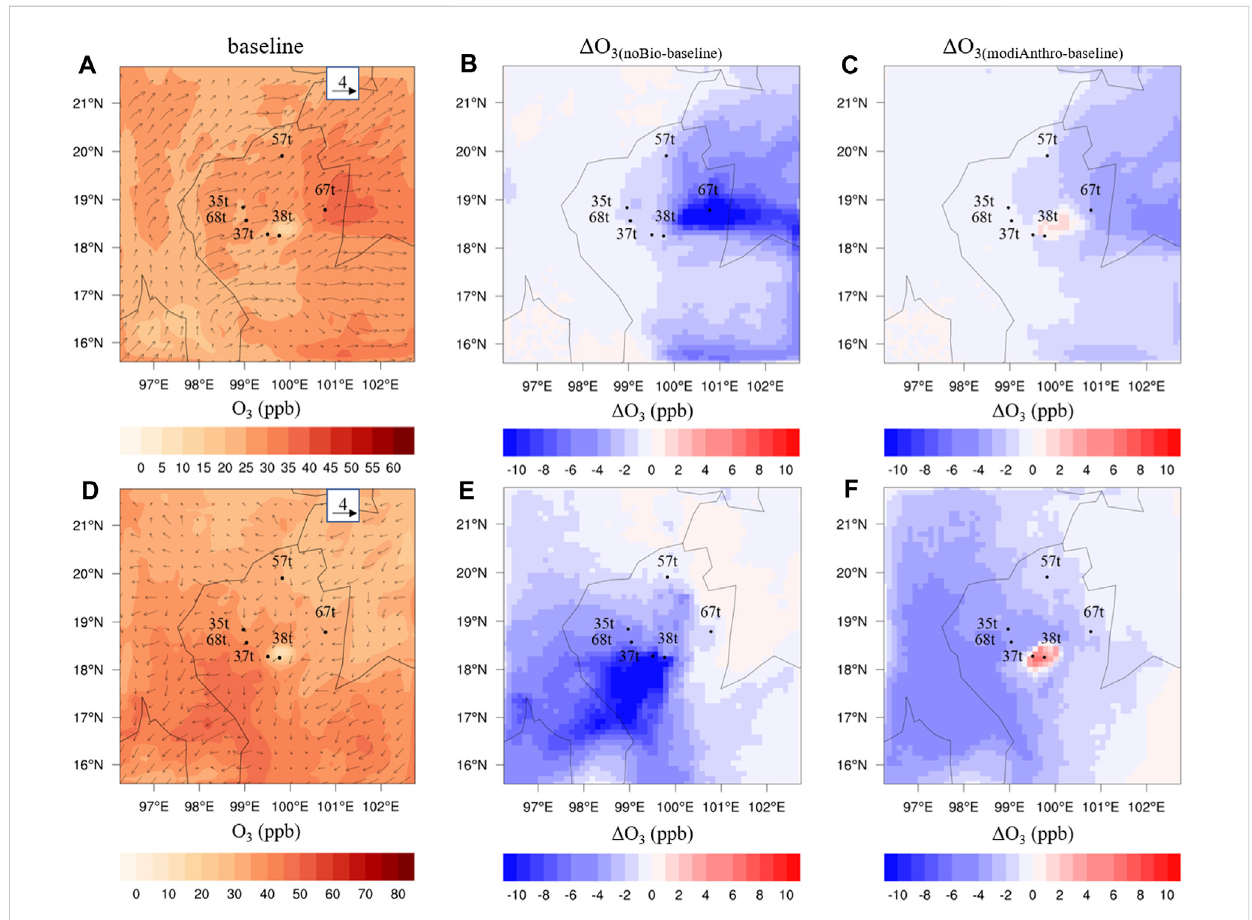
FIGURE 3 Spatial distribution of O 3 from baseline simulation with wind vectors (1st column), spatial distribution of Δ O 3(noBio-baseline) (2nd column), and Δ O 3(modiAnthro-baseline) (3rdcolumn)duringtheperiodfrom16to23Juneof2021 (A 2021 (D – F) , respectively. Reddish and bluish colors refer to an increase in O 3 and a decrease in O 3 concentration compared to the O 3 from the baseline simulations,